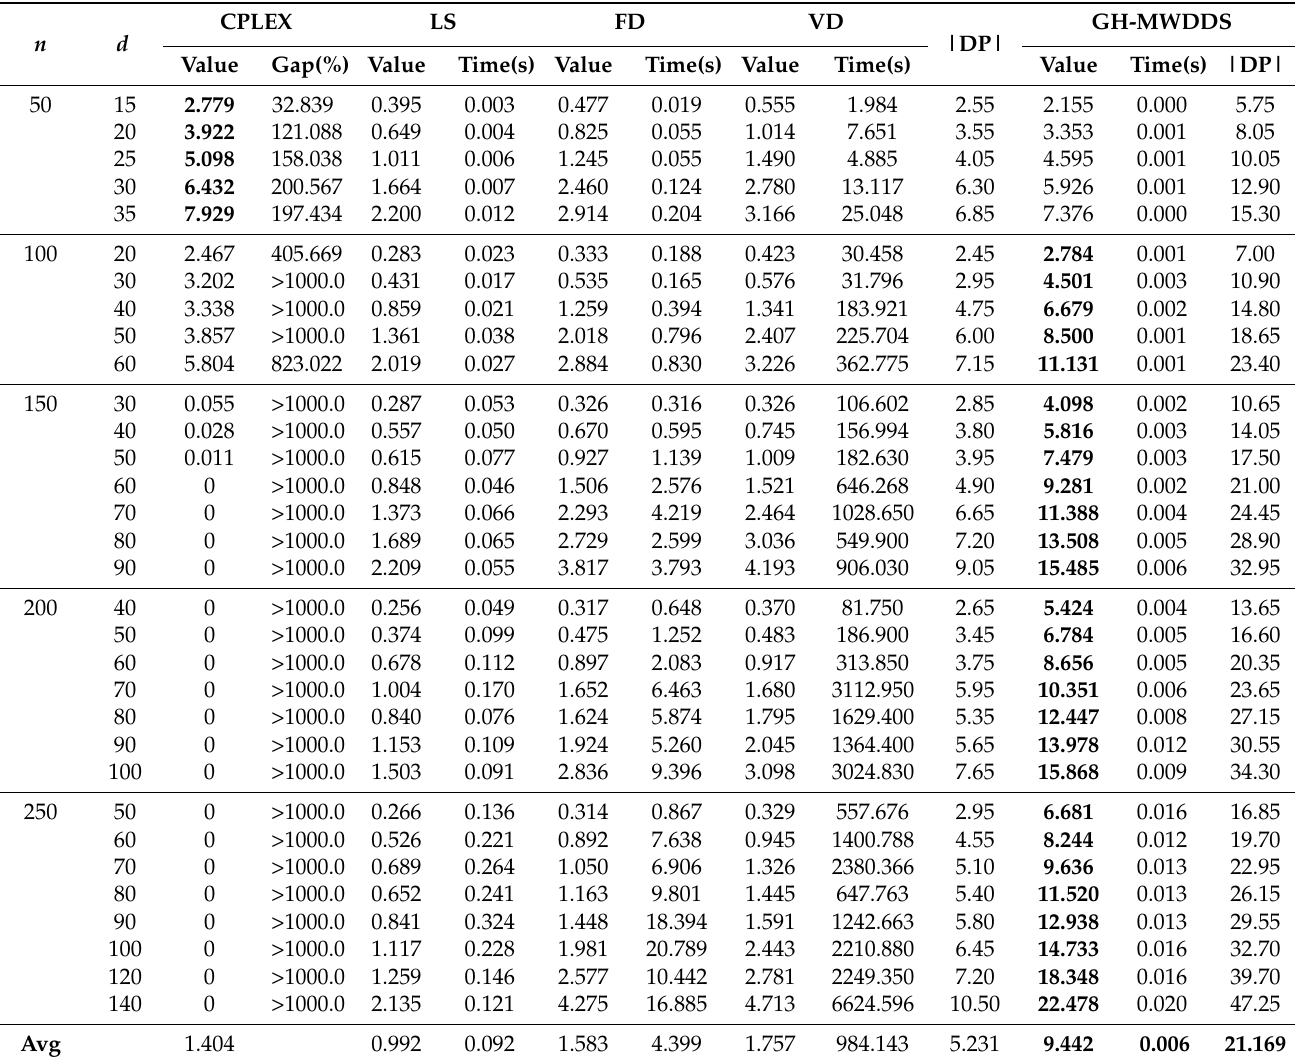
Table 1. Numerical results of comparison between LS, FD, VD and GH-MWDDS.